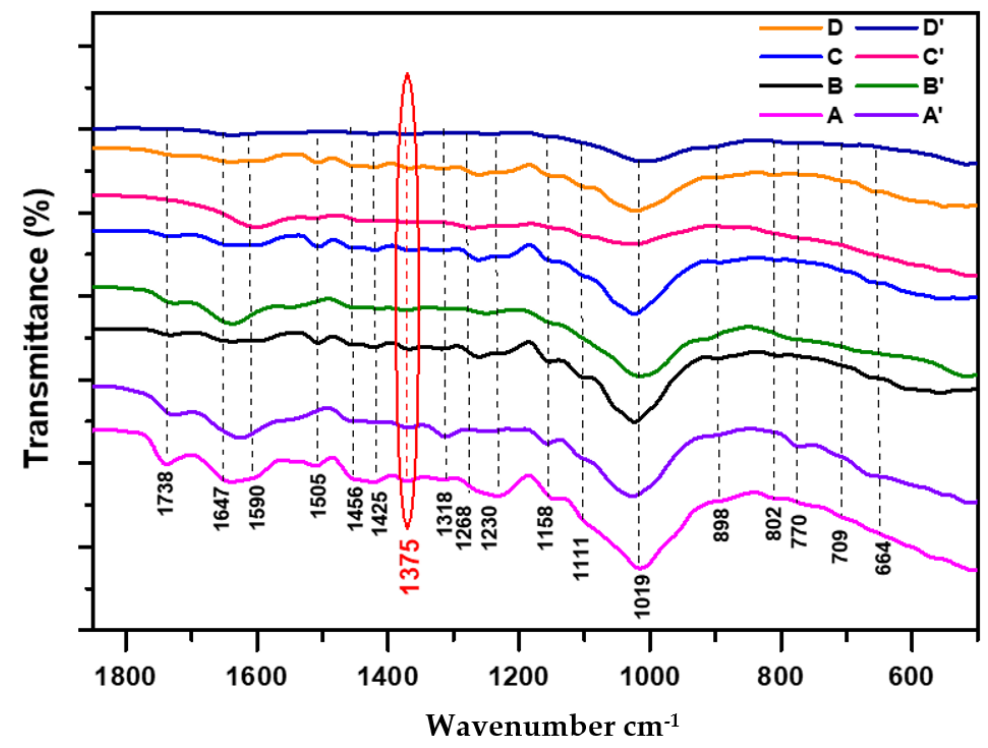
Figure 3. Superposition of FTIR spectra of both cedar wood samples normalized at 1375 cm −1 : non-degraded (A: 21st century, B: 19th century, C: 17th century, D: 16th century) and degraded (A’: 21st century, B’: 19th century, C’: 17th century, D’: 16th century).